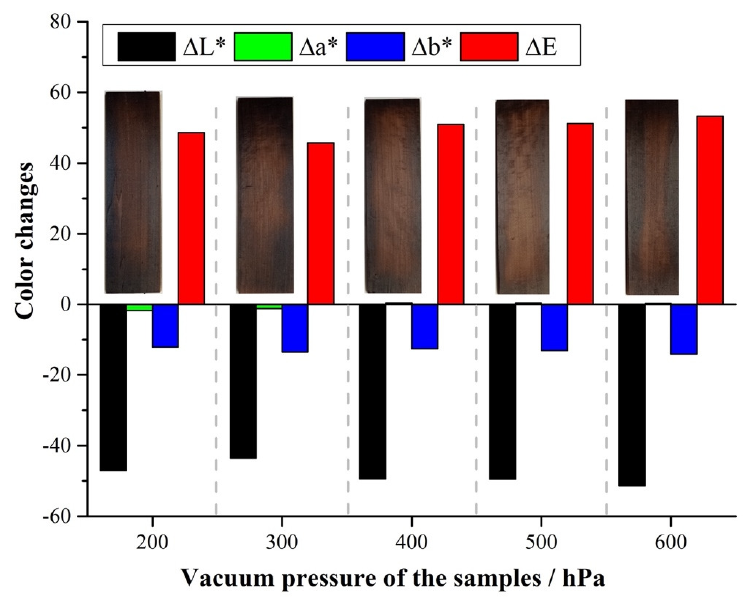
Figure 3. ∆ L*, ∆ a*, ∆ b*, and ∆ E for poplar samples treated under reduced pressure at 200–600 Figure 3. ∆L*, ∆a*, ∆b*, and ∆E for poplar samples treated under reduced pressure at 200–600 hPa. Indeed, when wood is thermally treated under reduced pressure, there is no stream of gas flowing during the experiment, which creates a stale atmosphere at a constant, pre- set pressure. The different levels of reduced pressure utilized during the experiment are obtained by the partial suppression of air inside the reactor. Therefore, increasing pres- sures represent an increase in the remaining Oxygen and moisture content inside the re- actor. It is believed that the residual oxygen in the reactor is responsible for promoting oxidation and degradation of polysaccharides, such as cellulose and hemicelluloses, there- fore increasing the relative concentration of lignin left in the treated sample. Due to the natural dark-brown color of lignin, samples that are richer in lignin exhibit a darker color, and are reflected in lower ∆L* values. The removal of oxidized/degraded polysaccharide fragments is facilitated by the reduced pressure. Any gaseous products formed during the experiment are immediately removed by the action of the vacuum pump employed in order to keep a consistent pre-set pressure throughout the experiment. It is therefore log- ical that darkening increases (lower ∆L* values) for higher pressures employed during experiments conducted under reduced pressure, as observed in Figure 3. Unlike for ∆L*, the different values measured for ∆a* (green/red) and ∆b* (yel- low/blue) aren’t statistically different across the samples analyzed (Figure 3), revealing that the main component responsible for the color changes observed is ∆L*. ∆E (Figure 3) increases as pressure increases. From the expression presented in Equation (2), lower ∆L* values lead to higher ∆E numbers. As expected, the trend observed in ∆E (Figure 3) cor- relates well with the results presented and shows that color change is indeed dominated by ∆L* behavior.